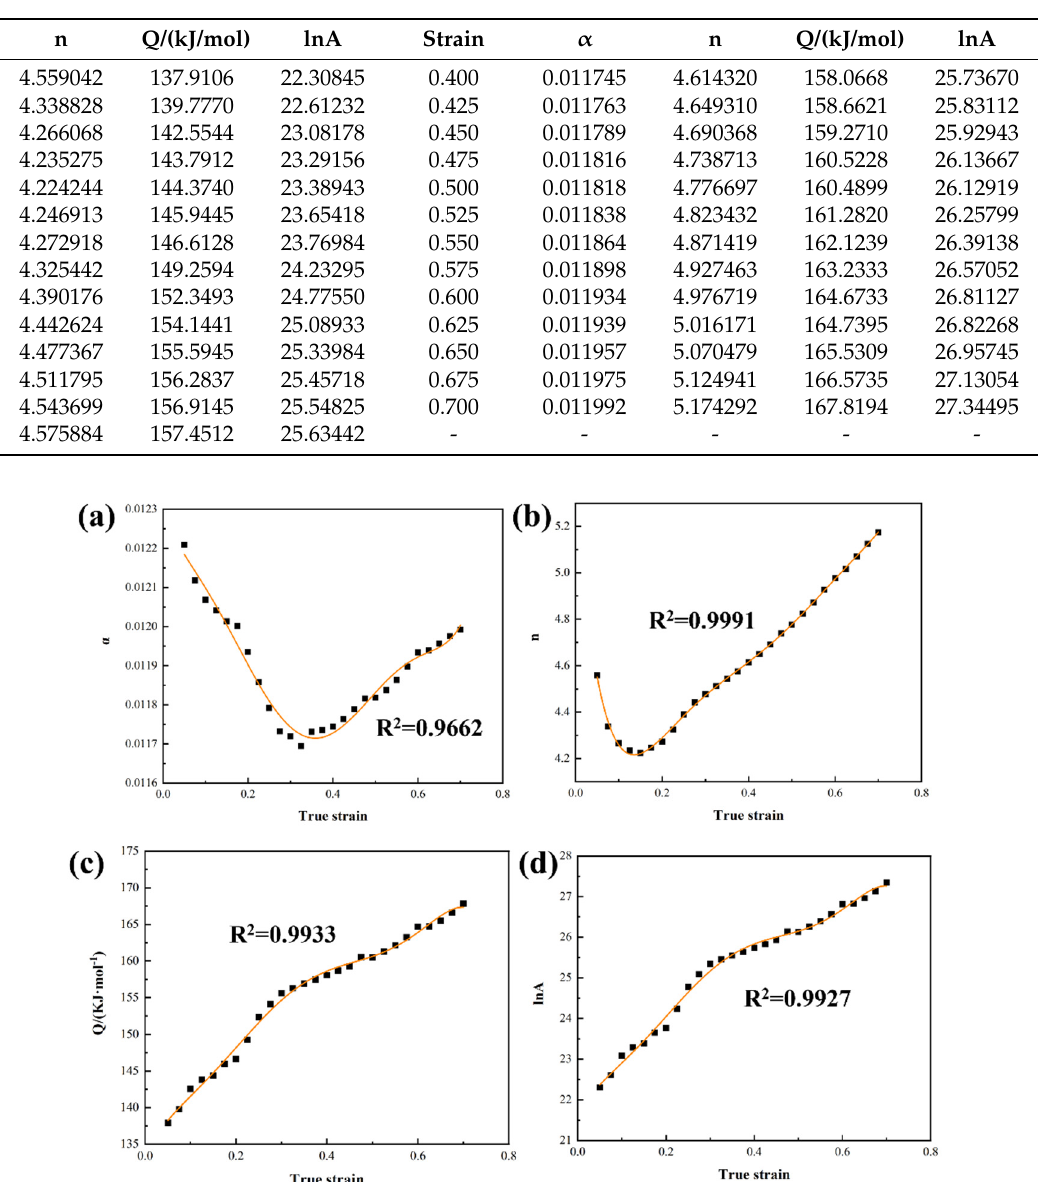
Figure 5. Relationship between various constitutive constants and true strain. ( a ) ε - α ; ( b ) ε -n; ( c ) ε -Q; ( d ) ε‐ lnA.